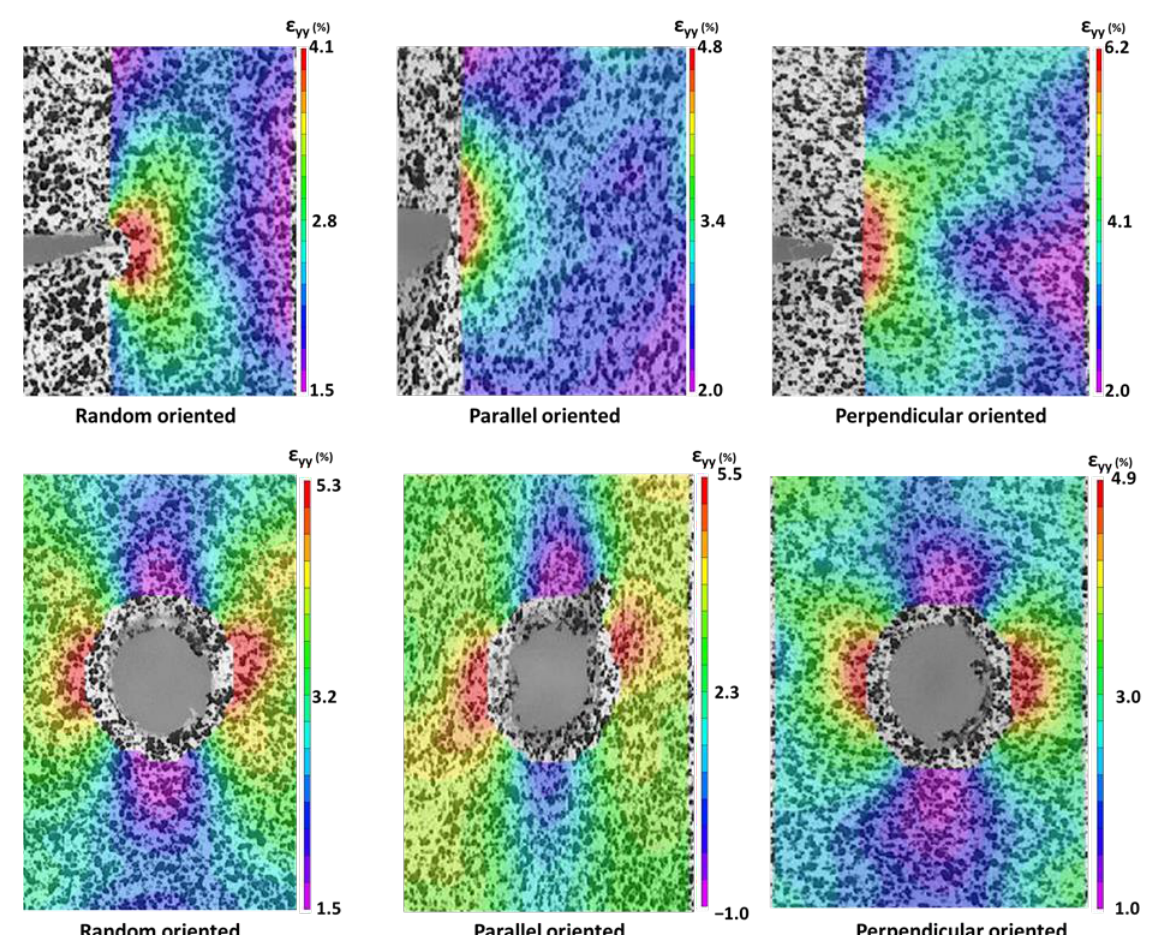
Figure 6. DIC inspection of the strain (y-direction) present around a notch for a random, parallel, and perpendicular oriented membrane.